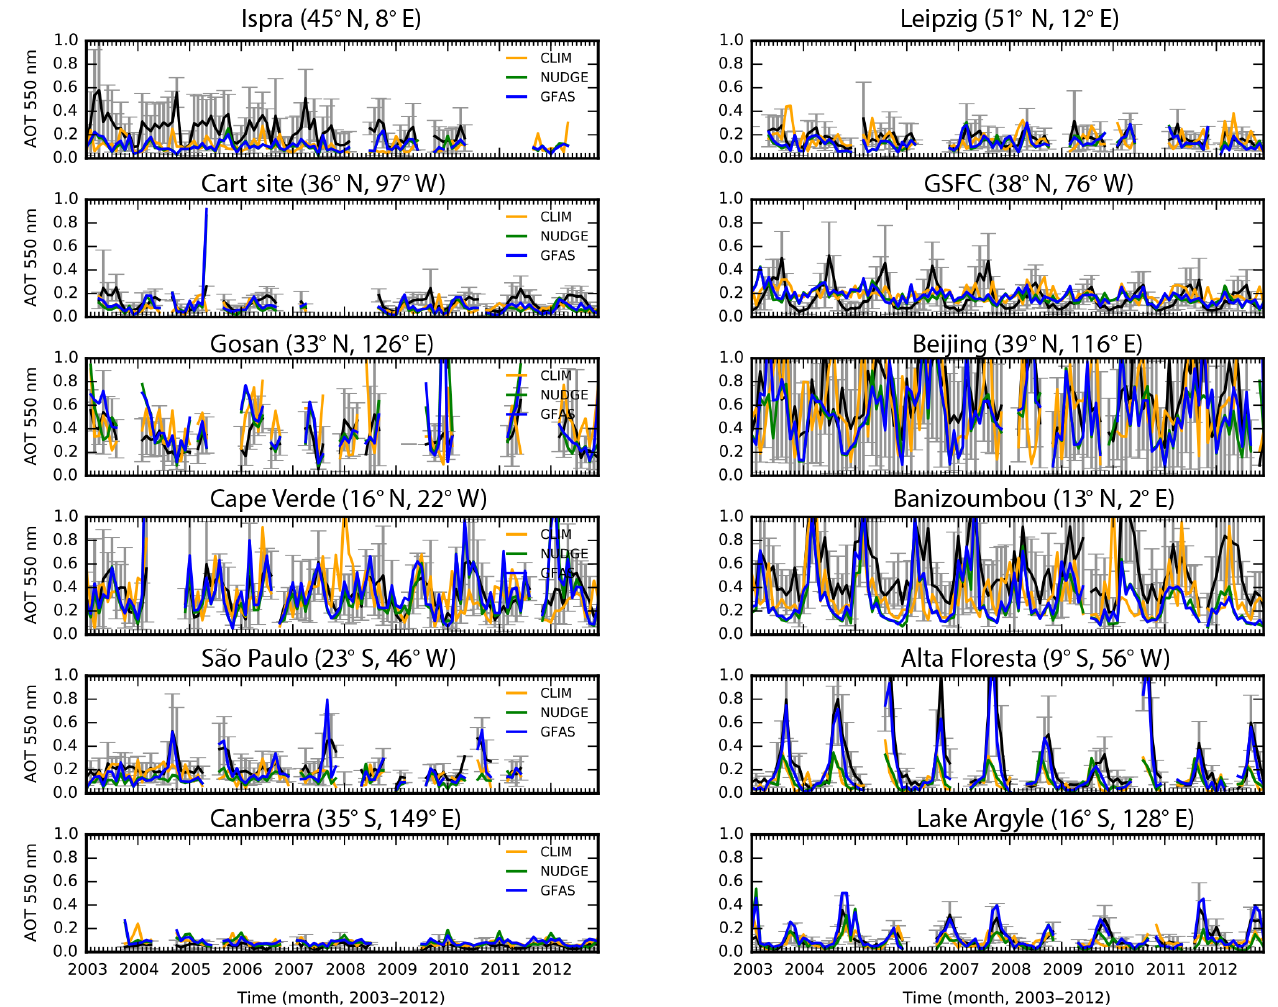
Figure 4. Time series (monthly means) of observed and simulated AOT (black line) from January 2003 to December 2012 at selected AERONET stations. Simulated monthly means were constructed from the daily mean outputs sampled on the same days of the observations and collocated to the observation position. Error bars show the standard variations due to daily variabilities in the measurements. Compared are model results for the CLIM (orange), NUDGE (green), and GFAS (blue)